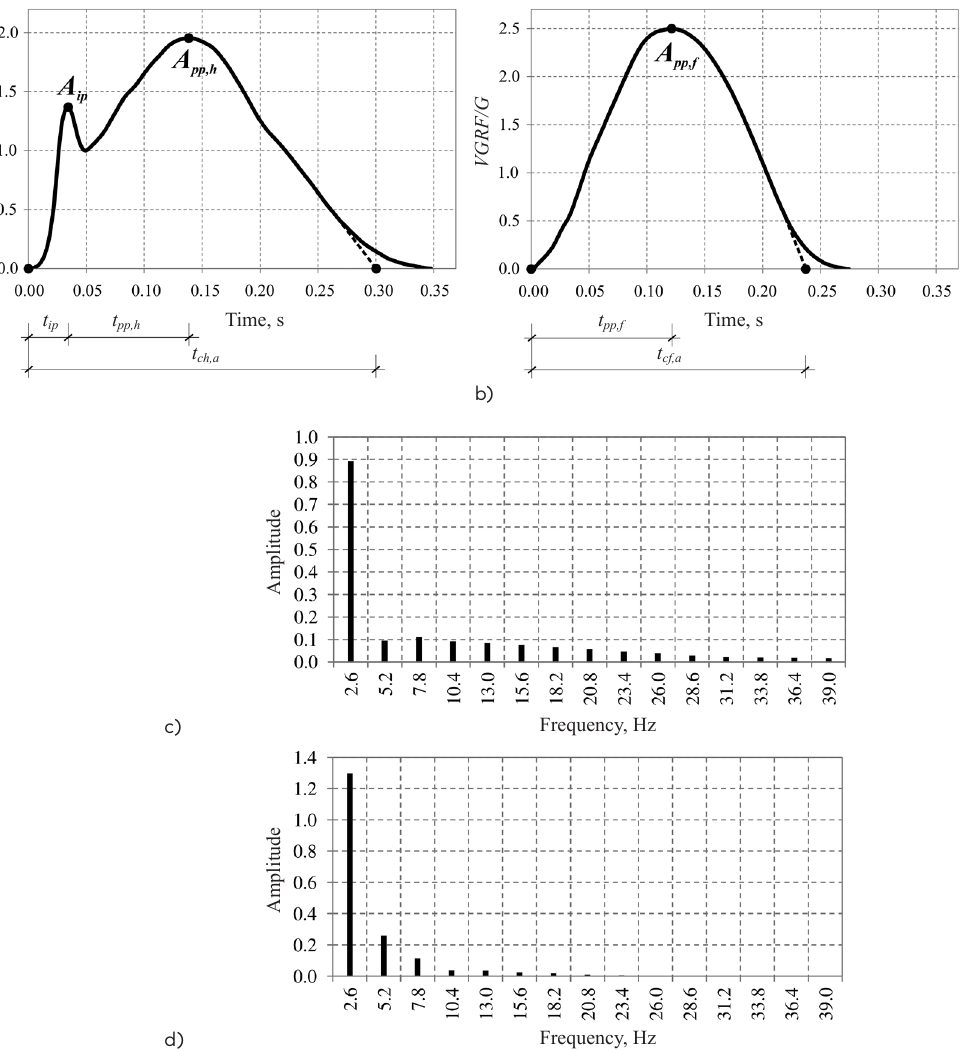
Figure 5. The VGRF / G curve indicators and example of the frequency content of the VGRF / G for a), c) heel-strike running technique, b), d) forefoot